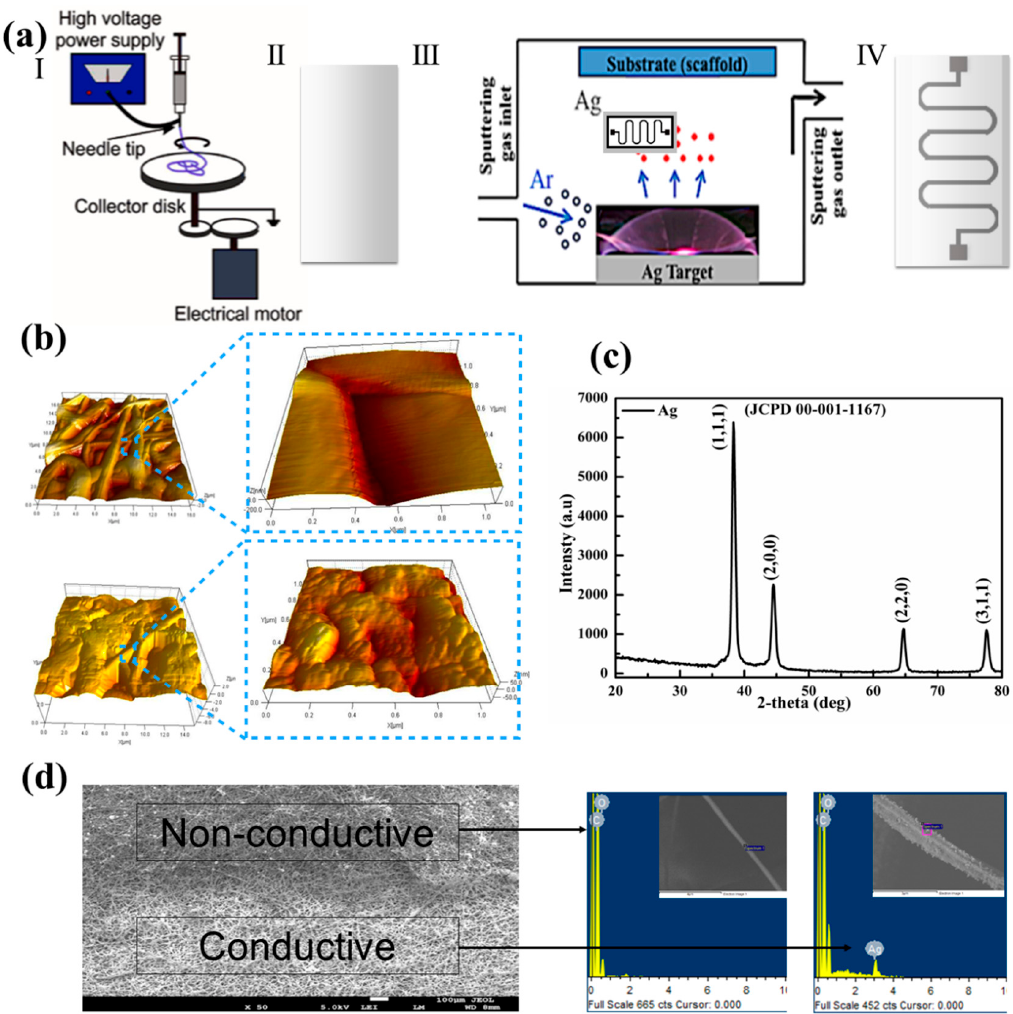
Figure 1. Fabrication and characterization of PCL/PGS-scaffold-substrate-based electronics. ( a ) Schematic of the electrospinning system used for fabricating sheets with uniform thickness ( i , ii ), schematic of the RF sputtering system used for fabricating a conductive pattern with a nano-sized silver coating ( iii ), and the tangible conductive scaffold with silver coating ( iv ). ( b ) Surface morphology of pristine and silver-coated nanofibers measured by an atomic force microscope (AFM). ( c ) X-ray diffraction (XRD) results for the silver coating on the scaffold substrate. ( d ) FESEM images of the PCL-PGS scaffold substrate showing the interface of the deposited patterns with an EDX spectra of the nanofibers (inset) on nonconductive and conductive areas showing Ag particle